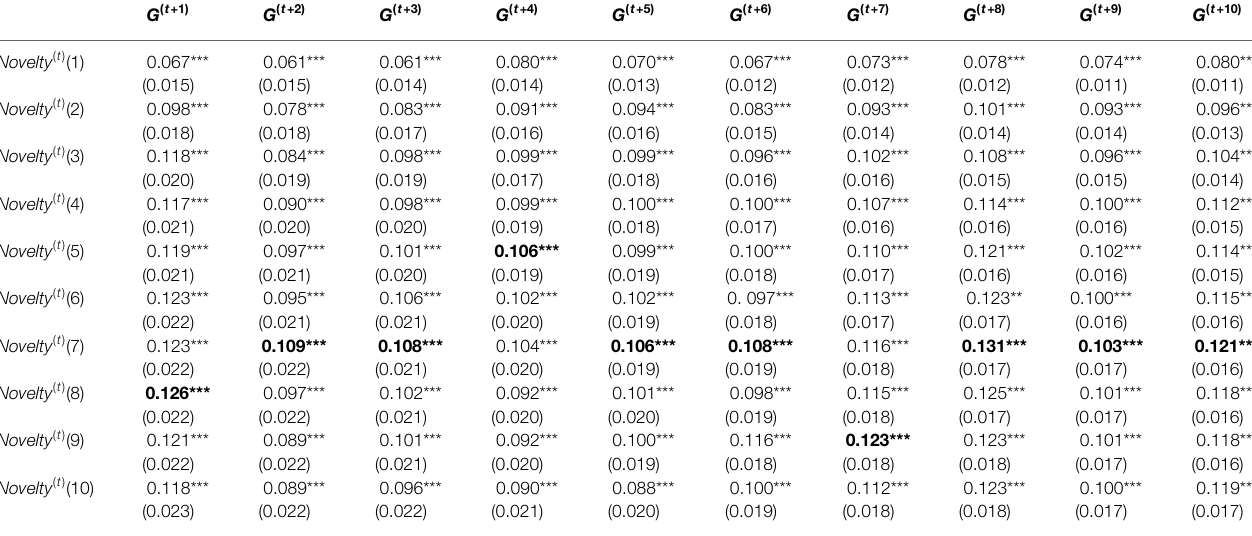
TABLE 1 | Estimates the effects of Novelty ( t ) on Growth ( t + ∆ t ) by random-effect